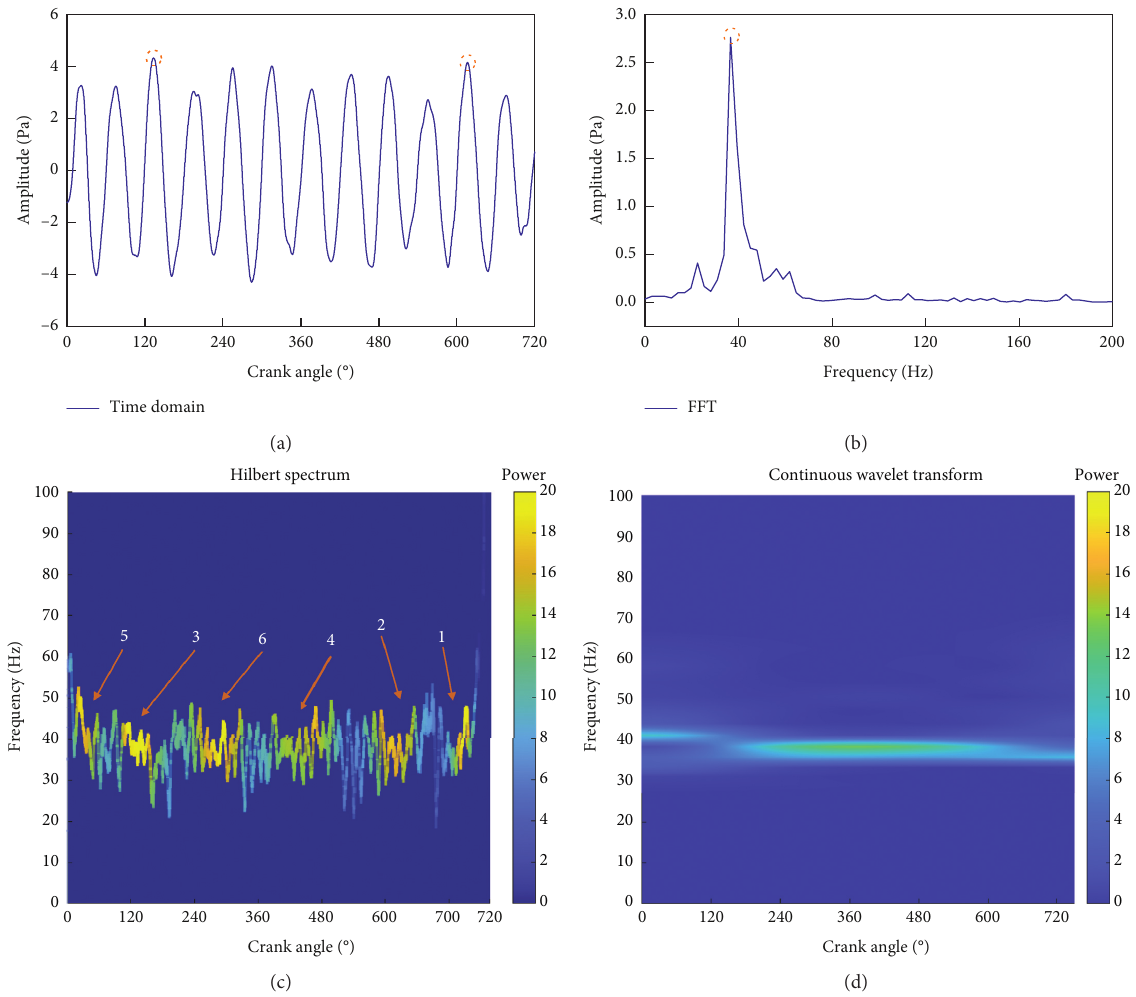
Figure 17: The results of the IC1 component separated by the VMD-FastICA method. (a) Time-domain waveform of IC1. (b) Fourier spectrum of IC1. (c) Hilbert spectrum of IC1. (d) Continuous wavelet transform of